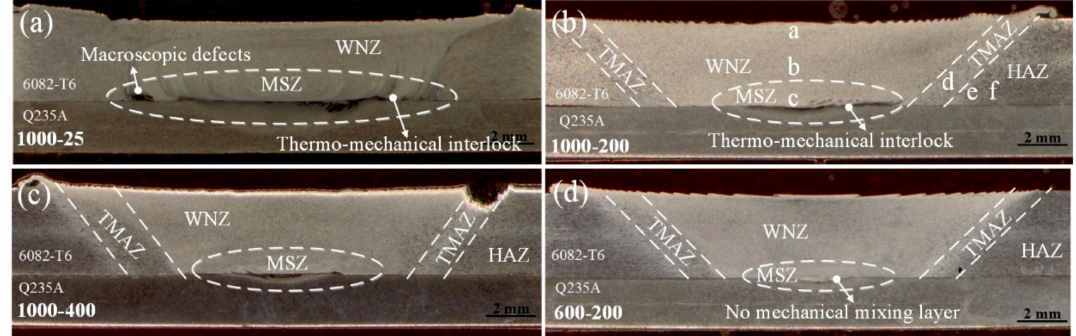
Figure 3. The comparison of macrostructure of Al/steel lap joint with different welding parameters. ( a ) 1000 rpm, 25 mm/min; ( b ) 1000 rpm, 200 mm/min; ( c ) 1000 rpm, 400 mm/min; and ( d ) 600 rpm, 200